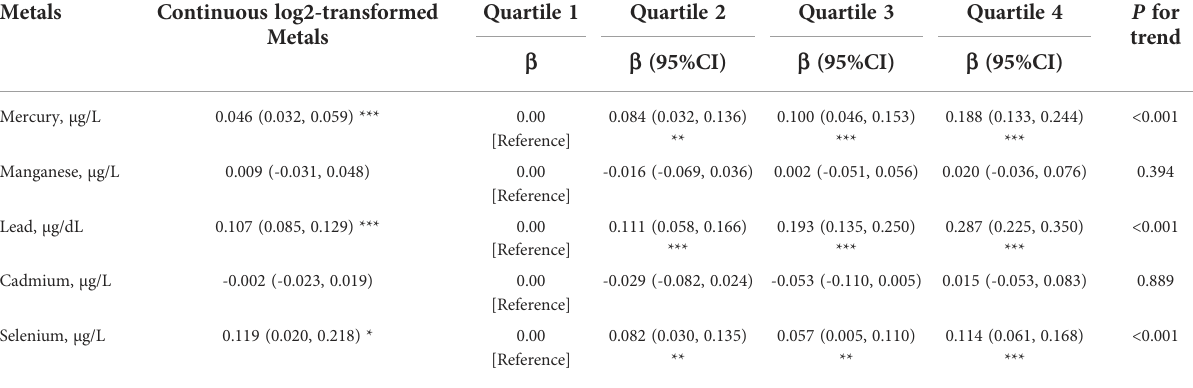
TABLE 2 Multiple linear regression associations of blood metal levels with serum uric acid in